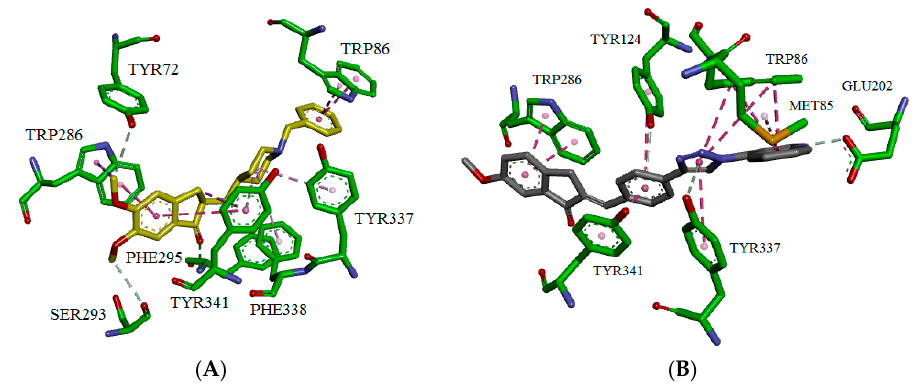
Figure 2. Molecular docking derived binding pose of donepezil ( A ) and compound 3h ( B ) in the binding sites (CS and PAS) of AChE enzyme. GOLD software was used to derive the binding mode and the picture was generated from DS Visualizer software.